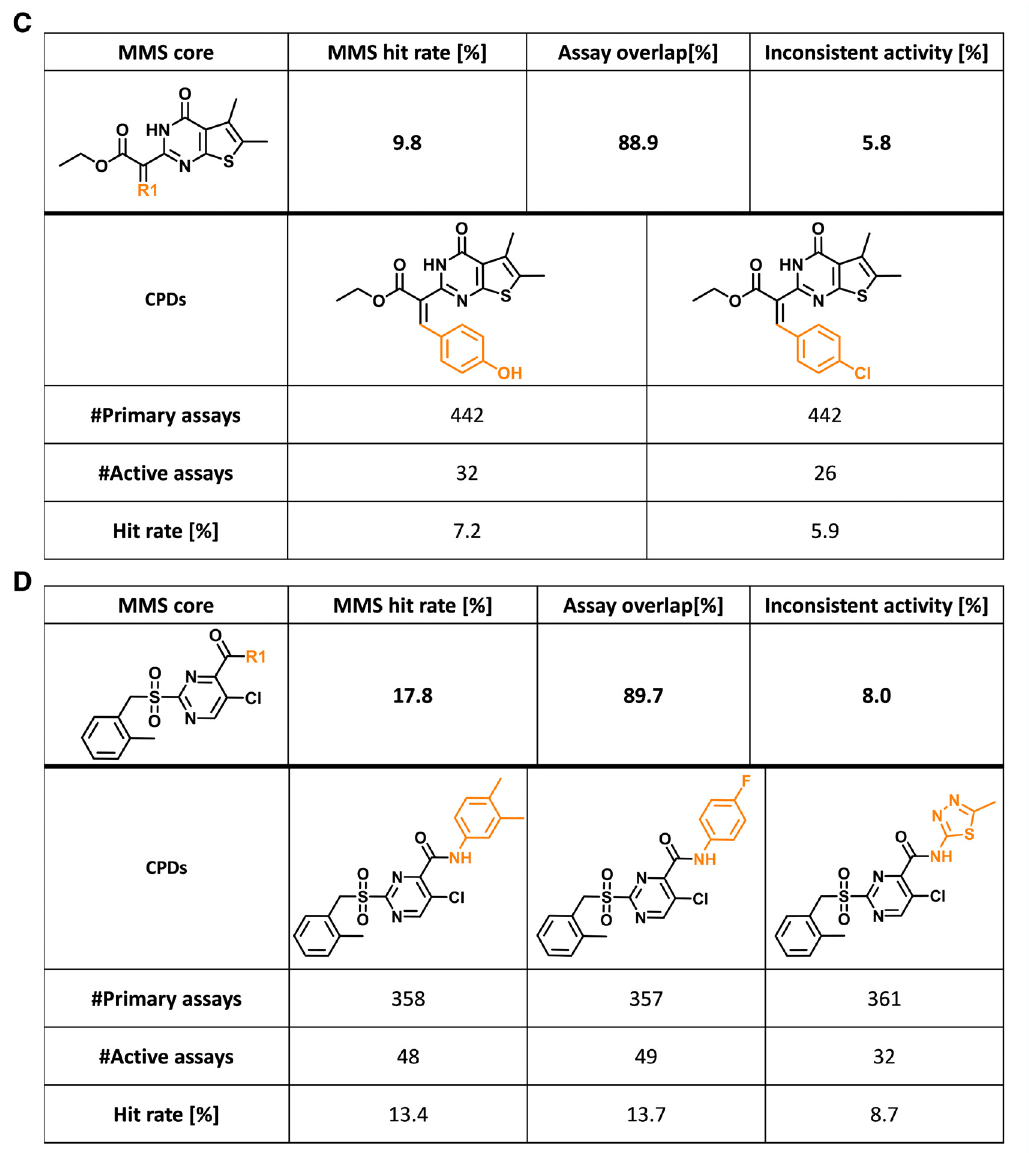
Figure 4. Exemplary matched molecular series (MMSs). ( a – d ) Four exemplary MMSs (core, black; substituents, orange) are shown and the MMS hit rate, assay overlap, and proportion of assays with inconsistent activity are reported. In addition, for each individual analog, its assay frequency and hit rate are